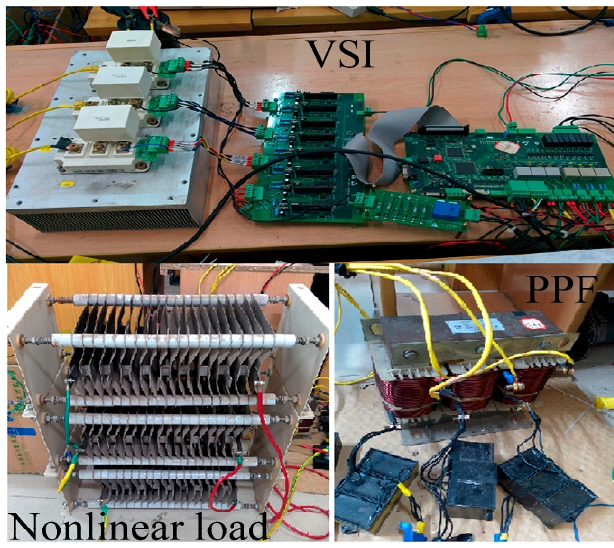
Figure 8. Photograph of the prototype. Table 1. Experimental